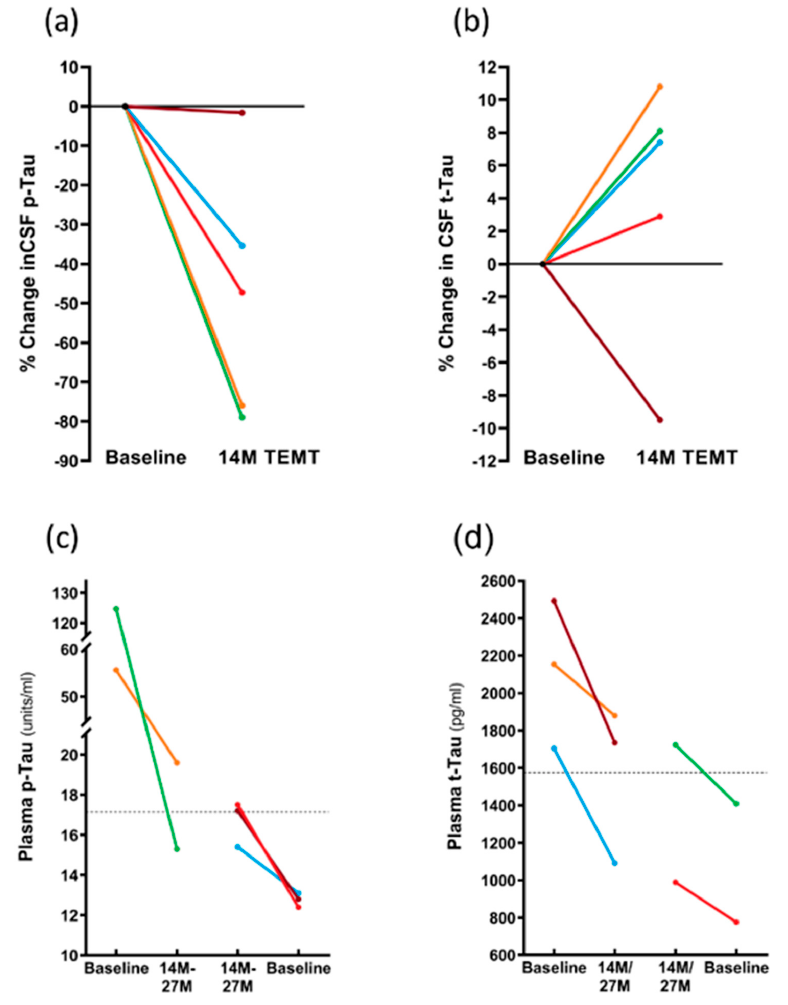
Figure 9. ( a , b ) For individual subjects, effects of 14M TEMT on percent change in CSF levels of p-tau217 ( a ) and t-tau. ( c , d ) Effects of 14–27M TEMT on plasma levels of p-tau217 ( c ) and t-tau ( d ) for individual subjects. Each color represents results from the same subject.